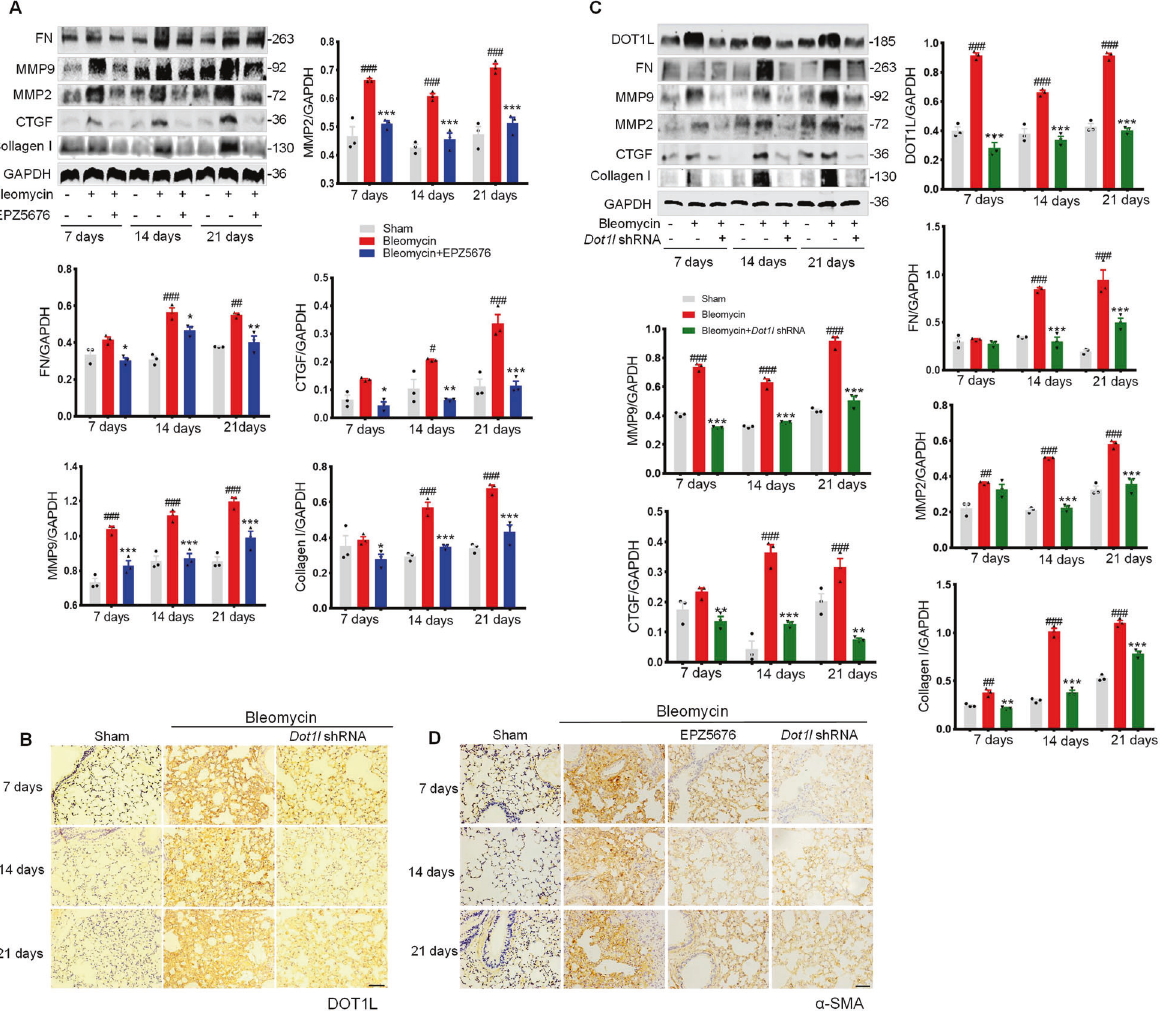
Fig. 2 DOT1L disruption inhibits bleomycin-induced mouse pulmonary fi brosis in vivo. A The expression levels of FN, MMP9, MMP2, CTGF, and Collagen I were examined by western blot in bleomycin-induced mice after treatment with EPZ5676 for 7, 14, and 21 days, respectively. B Representative immunohistochemistry staining of DOT1L in the lung sections from bleomycin-induced mice after treatment with Dot1l shRNA for 7, 14, and 21 days, respectively. Scale bars: 50 μ m. C Immunoblot analysis of DOT1L and fi brosis-associated proteins (FN, MMP9/2, CTGF, and Collagen I) in bleomycin-induced mice after treatment with Dot1l shRNA for 7, 14, and 21 days, respectively. D Representative immunohistochemistry staining of α -SMA in the lung sections from bleomycin-induced mice after treatment with EPZ5676 or Dot1l shRNA for 7, 14, and 21 days, respectively. Scale bars: 50 μ m. All data are presented as mean ± S.D.; n = 6 – 10/group, # p < 0.05, ## p < 0.01, ### p < 0.001 compared with the sham group; * p < 0.05, ** p < 0.01, *** p < 0.001 compared with the bleomycin